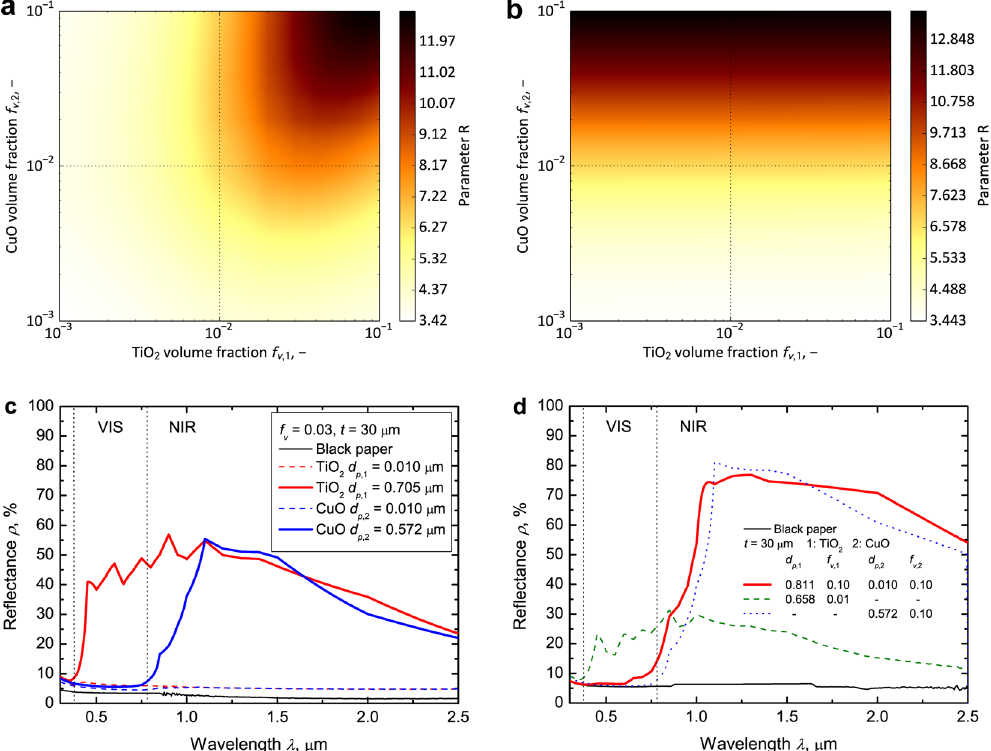
Figure 3. Effect of volume fraction on the optimization parameter when the VIS controlling particle is CuO and the NIR reflecting particle is TiO 2 . ( a ) Color map of R when d p ,1 is 0.705 μ m and d p ,2 is 0.010 μ m. R is maximum ( R = 12.89) when f v ,1 is 0.09 and f v ,2 is 0.10. ( b ) Color map of R when d p ,1 is 0.010 μ m and d p ,2 is 0.572 μ m. R is maximum ( R = 13.76) when f v ,1 is 0.001 and f v ,2 is 0.10. ( c ) Calculated spectral reflectance of the TiO 2 pigmented coating when the d p ,1 values are 0.010 μ m (red dashed curve) and 0.705 μ m (red bold curve) and that of the CuO pigmented coating when the d p ,2 values are 0.010 μ m (blue dashed curve) and 0.572 μ m (blue bold curve). ( d ) Calculated spectral reflectance of C 3 when d p ,1 is 0.811 μ m, f v ,1 is 0.10, d p ,2 is 0.010 μ m, and f v ,2 is 0.10 (red bold curve; R = 13.93) and that when d p ,1 is 0.010 μ m, f v ,1 is 0.01 (green dashed curve; R = 3.84), d p ,2 is 0.572 μ m, f = 13.79), and black paper (black v ,2 is 0.10 (blue dotted curve; R